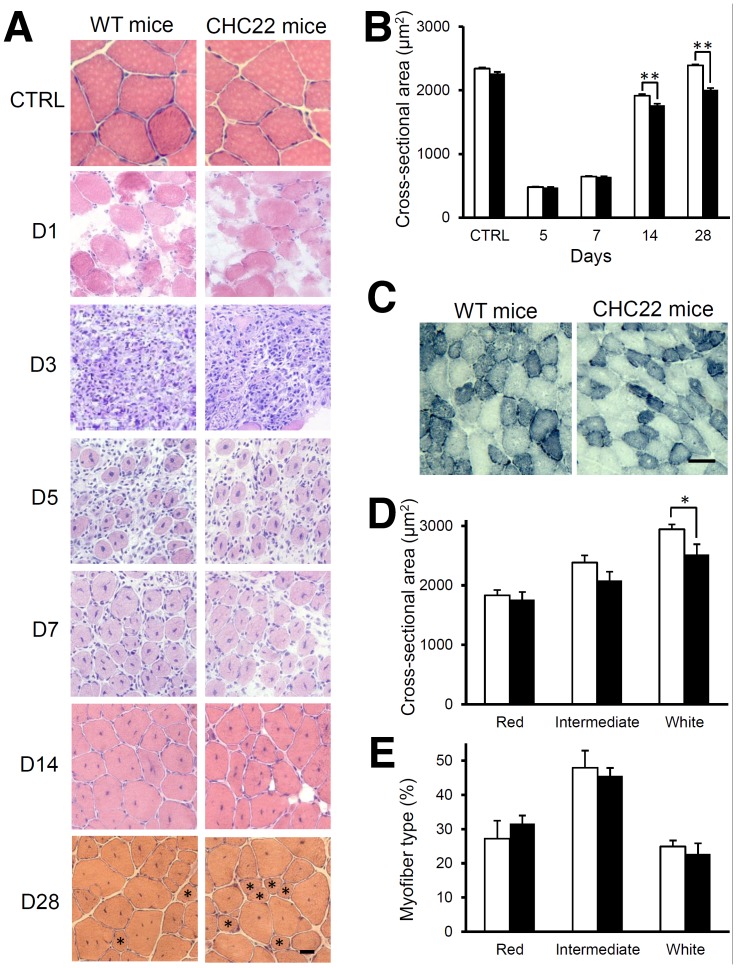
Delayed maturation and fiber type analysis of regenerating fibers in CHC22-transgenic mice.A) Hematoxylin and eosin staining of transverse muscle sections from WT or CHC22 transgenic mice after cardiotoxin injection at day 0, on the indicated days (D). Control (CTRL) sections were prepared from uninjured muscle. On day 28, some CHC22 myofibers were similar in cross-sectional area and diameter to WT myofibers; however, smaller myofibers (<40 µm diameter, marked by asterisks) were more frequently observed in the CHC22-mice compared to WT mice (scale bar, 20 µm; n = 3). B) The mean cross-sectional area of myofibers with centrally located nuclei from WT (white bars) and CHC22-mice (black bars) was calculated and plotted for each indicated day after cardiotoxin injection. Control mice for each strain were not injected with cardiotoxin. There was a statistically significant difference in the average fiber cross-sectional area between WT mice and CHC22-mice on days 14 and 28 after injection (n = 3, evaluating 1200–2000 myofibers per mouse; **p<0.01), as determined by Student’s t test. C) Transverse sections of muscle from CHC22-mice and WT mice, harvested 28 days after cardiotoxin injection, were stained for NADH-TR in order to determine the myofiber type. Oxidative (red) myofibers appear dark, glycolytic (white) myofibers appear light and intermediate (pink) myofibers appear intermediate in color. D) Fibers in 28-day regenerating muscle from CHC22-mice (black bars) and WT mice (white bars) were classified by type and their cross-sectional area measured in pixels using ImageJ (n = 3, evaluating ∼1500 fibers per mouse, *p<0.05, by Student’s t test). E) The percent of each fiber type in 28-day regenerating muscle from CHC22-mice (black bars) and WT mice (white bars) from the analysis in D is plotted.